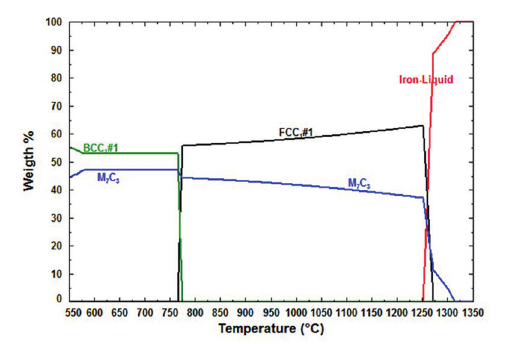
Figure 8: Equilibrium diagram for the FeCrC wire used as hardfacing added